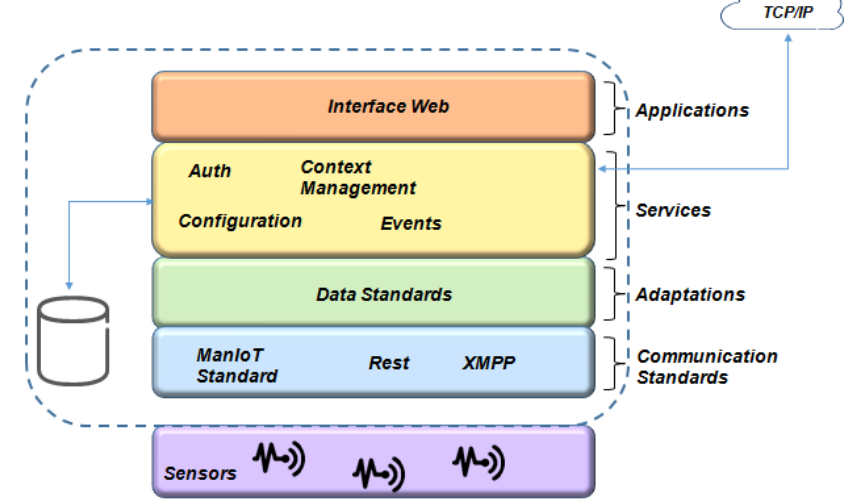
Figure 22. ManIoT: Local Management Architecture.